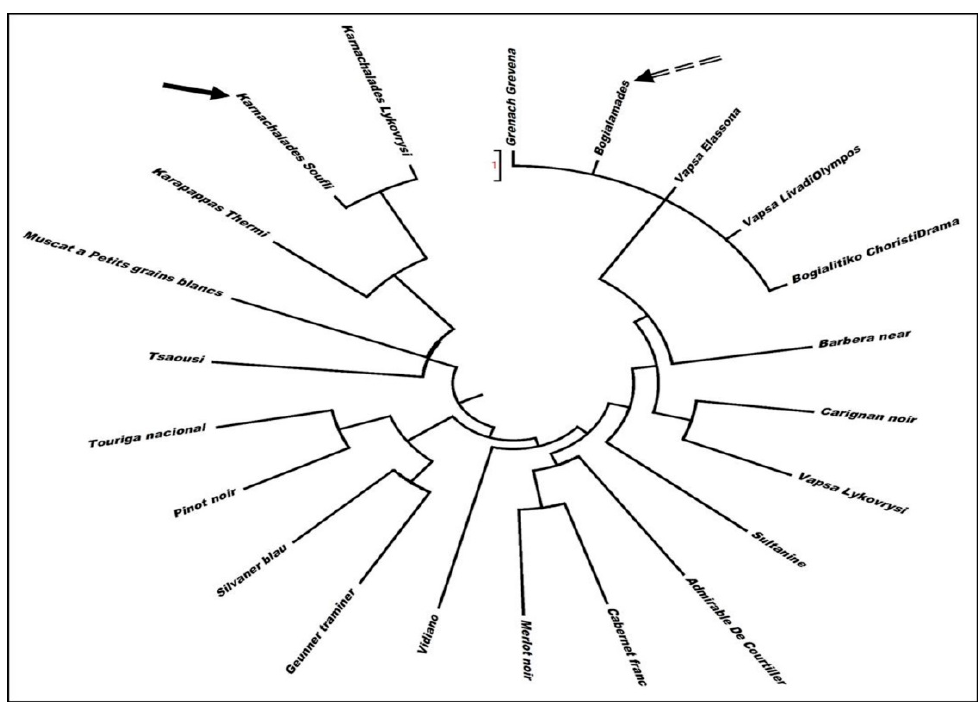
Figure 2. UPGMA dendrogram showing genetic relationship of the Soufli varieties to the international ones.